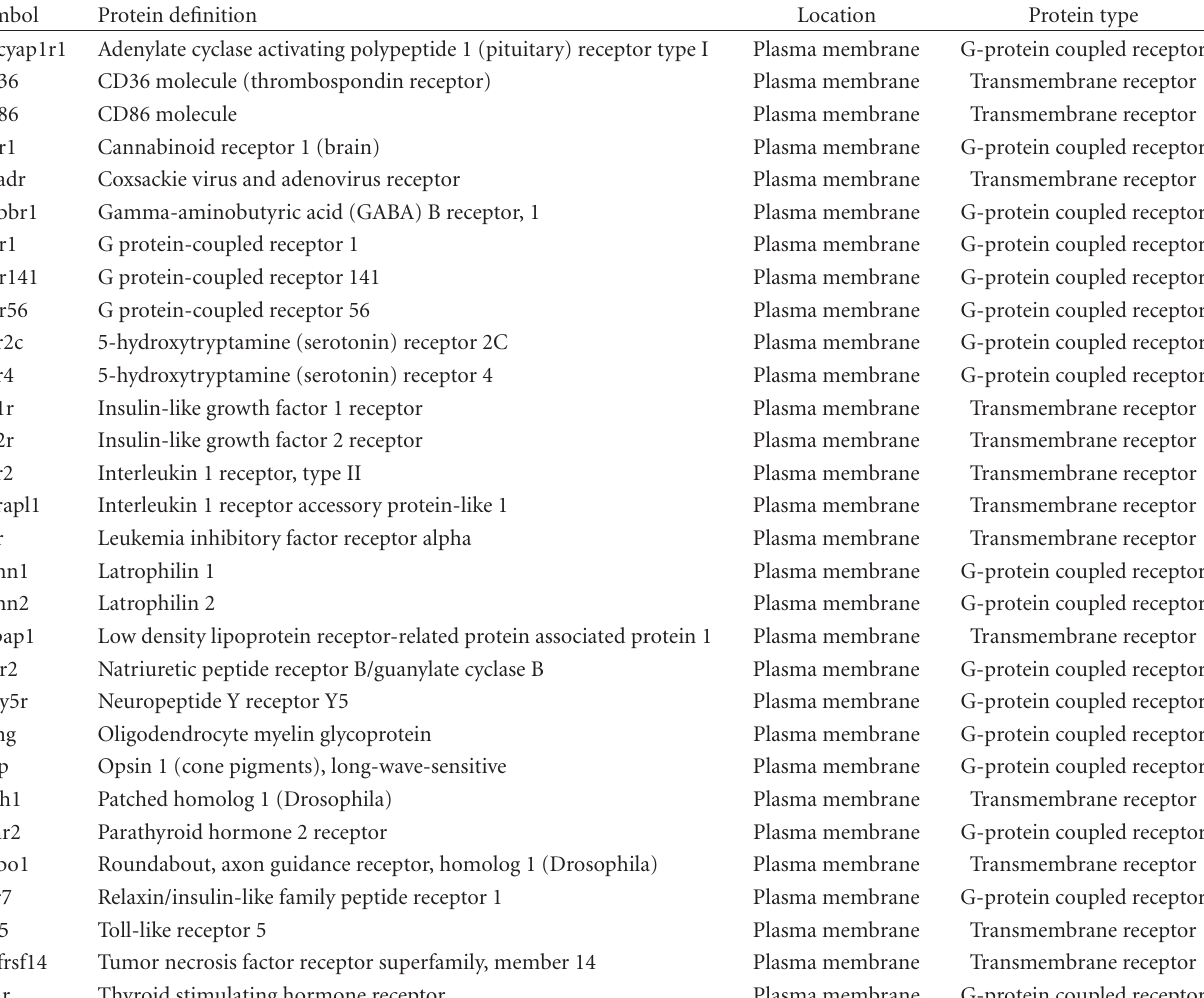
Table 2: Receptor-specific protein list from lipid raft extracts from 3xTgAD animals . Primary protein lists of extracted lipid raft proteins were filtered for a specific receptor profile using IPA v.